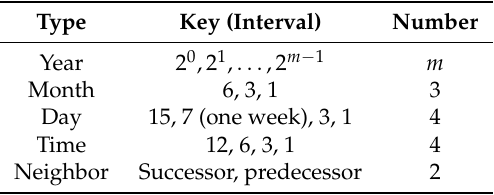
Table 1. The types, keys, and number of the constructed